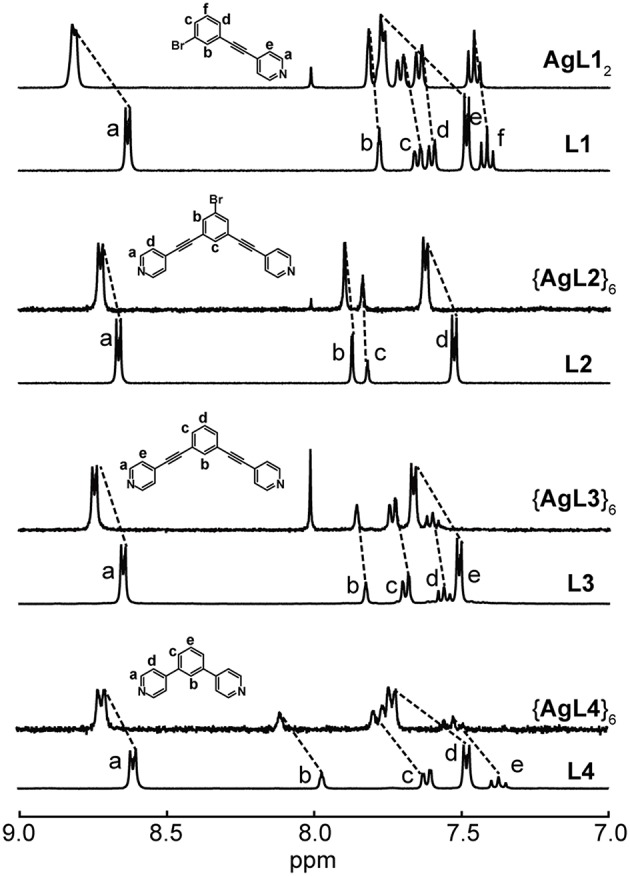
1H NMR spectra of L1 and AgL12, L2 and {AgL2}6, L3 and {AgL3}6 and L4 and {AgL4}6 in acetone-d6.